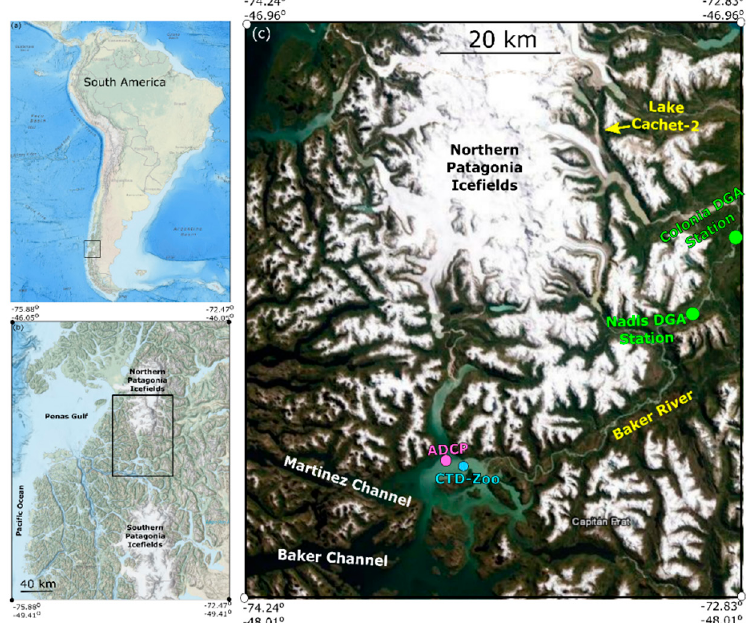
Figure 1. ( a ) Study area in relation to South America. ( b ) Close up of study area identifying the Northern and Southern Patagonia Icefields. ( c ) Further close up identifying the Acoustic Doppler Current Profiler (ADCP) mooring and Conductivity, Temperature, Depth (CTD) station location within Martinez Channel, the Baker River, the location where river discharge measurements were collected (DGA stations) and Lake Cachet-2, where the glacial lake outburst floods (GLOFs) begin. These figures were modified from data available by the National Oceanic and Atmospheric Administration (NOAA) Bathymetry Viewer.